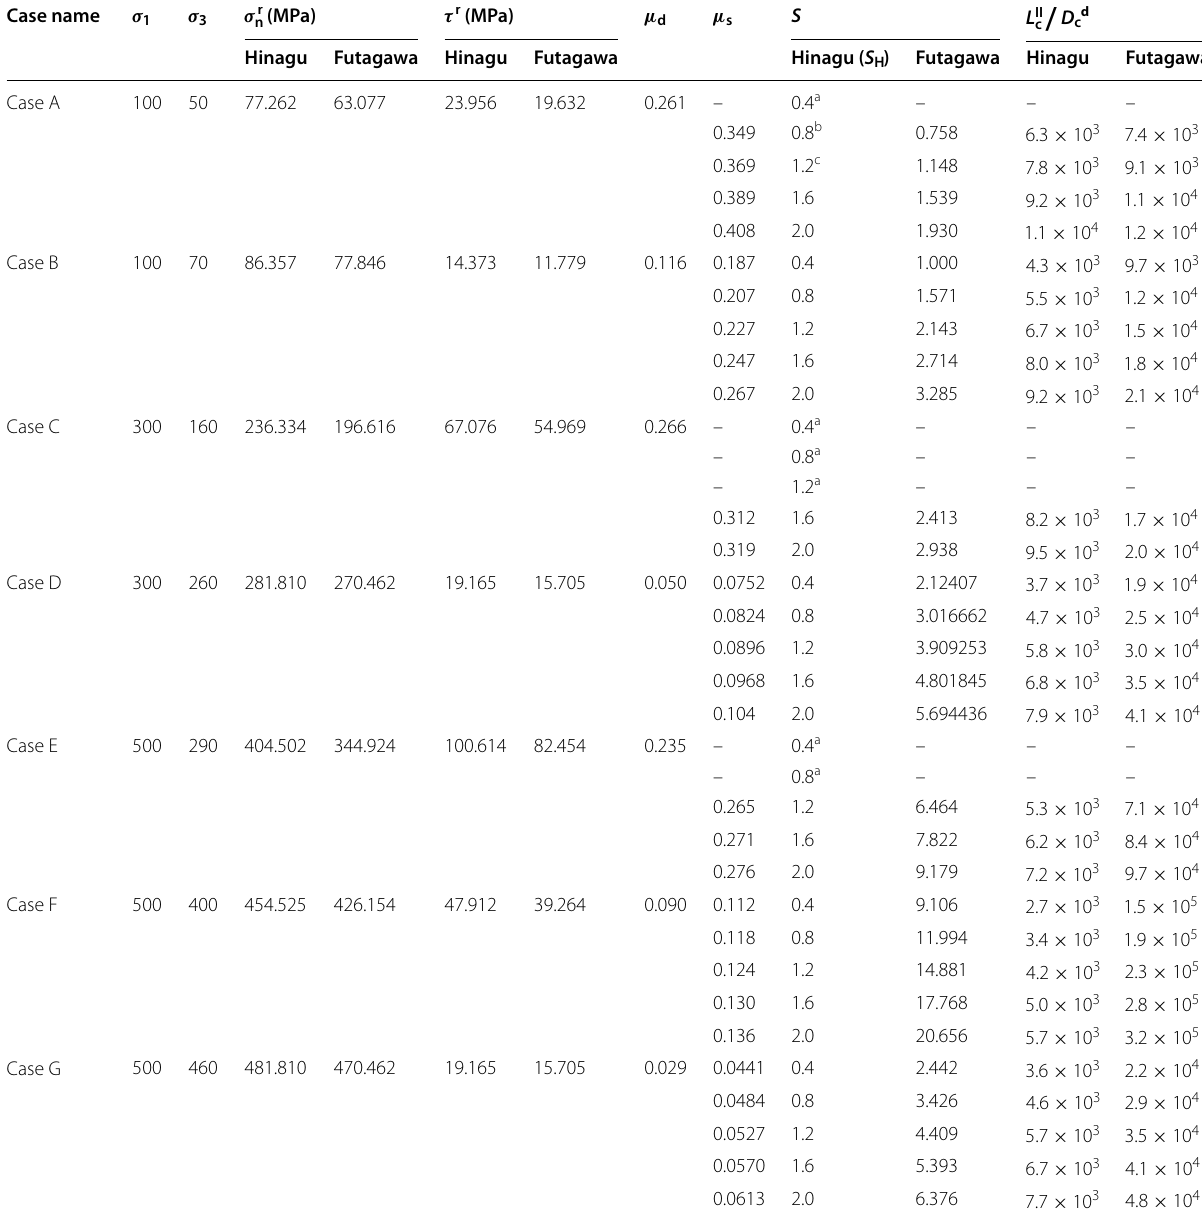
Table 3 Estimated µ d , assumed µ s , and calculated S and L